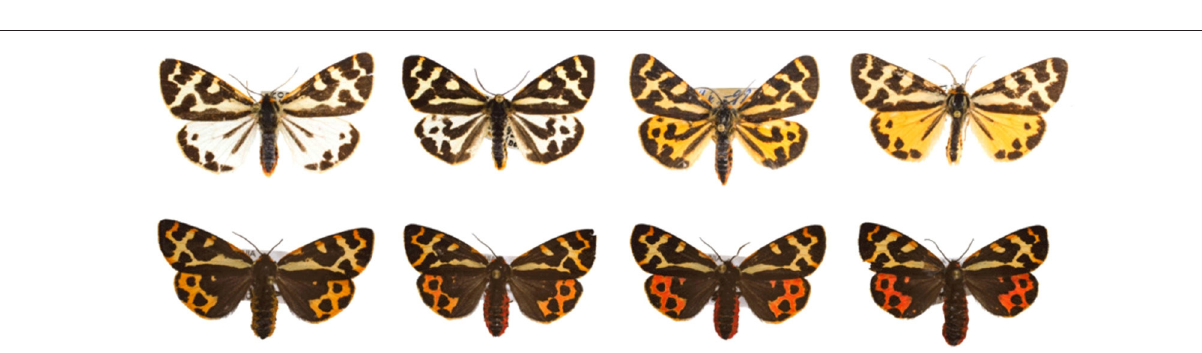
geographic distribution across the holarctic region (Hegna et